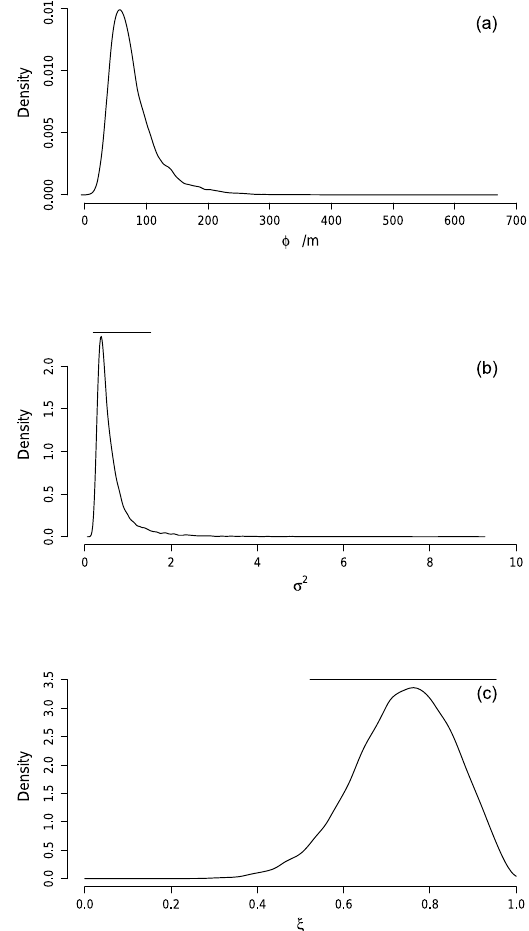
Figure 3. Empirical probability density functions for variogram pa- rameters: φ (a) , σ 2 (b) and ξ (c) . These were obtained from the MCMC samples. Horizontal bars show the 95% credible interval for each